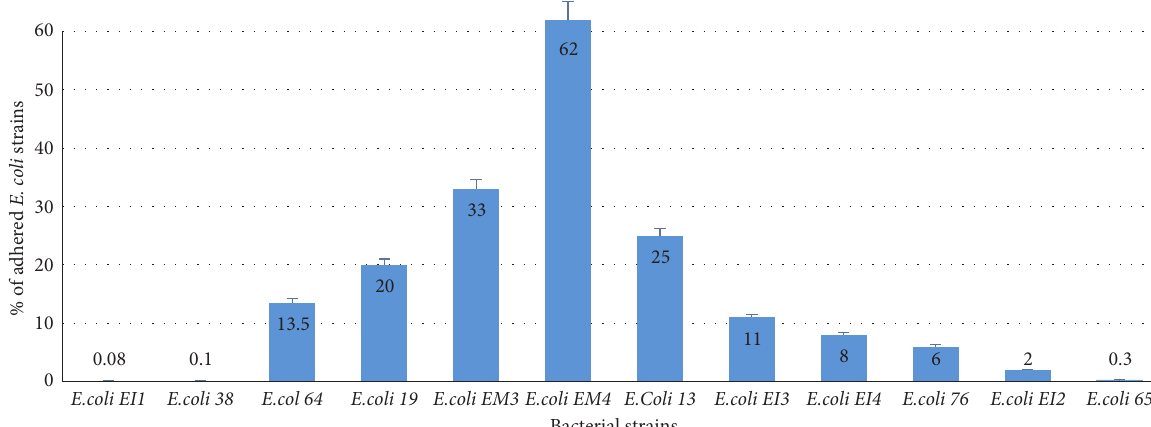
Figure 2: Percentages of the adhered cells of E. coli strains on glass substratum. Error bars represent standard deviations of the percentages of the occupied surface by bacteria. Adhesion assays were conducted with three